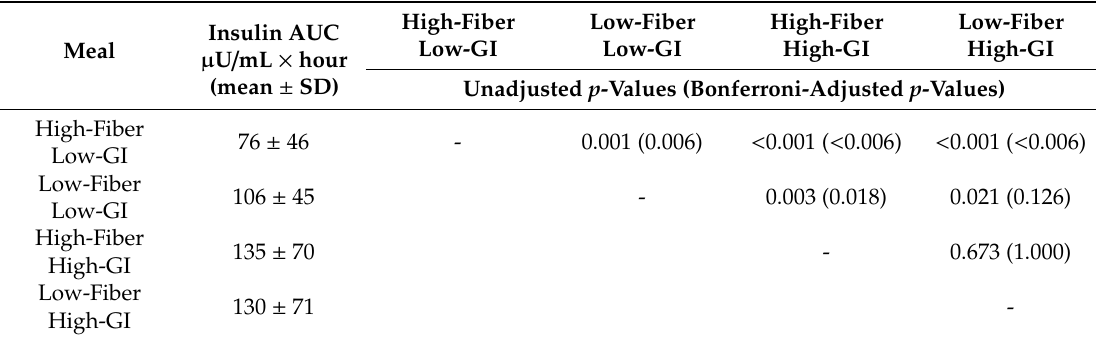
Table 5. Insulin area under curve: Comparisons between